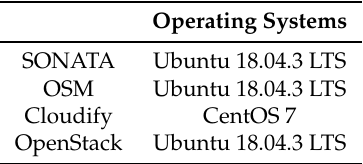
Table 3. Operating Systems.